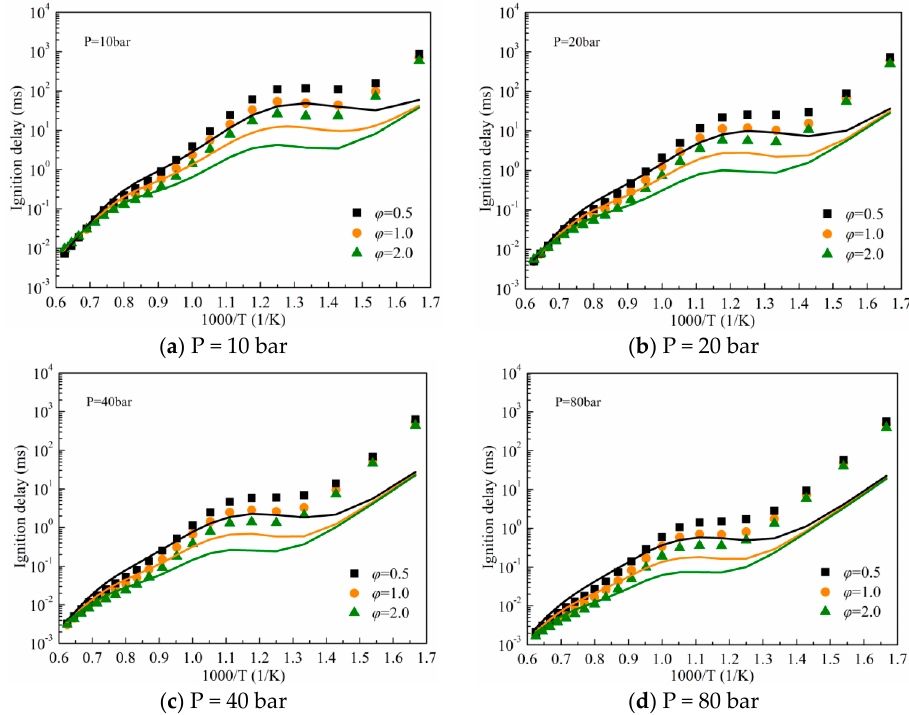
Figure 3. Predicted ignition delays of MTHF2 by detailed mechanism [17] (symbols) and reduced mechanism (lines) based on DRGEP + RPA+ isomers lumping.